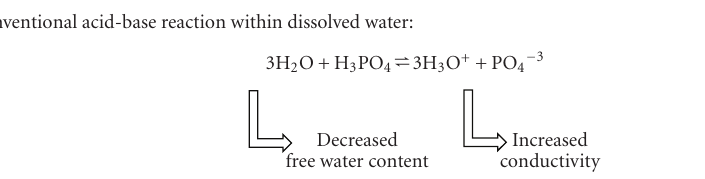
Figure 1: Chemical reactions following the take-up of water into a phosphate-ester based hydraulic